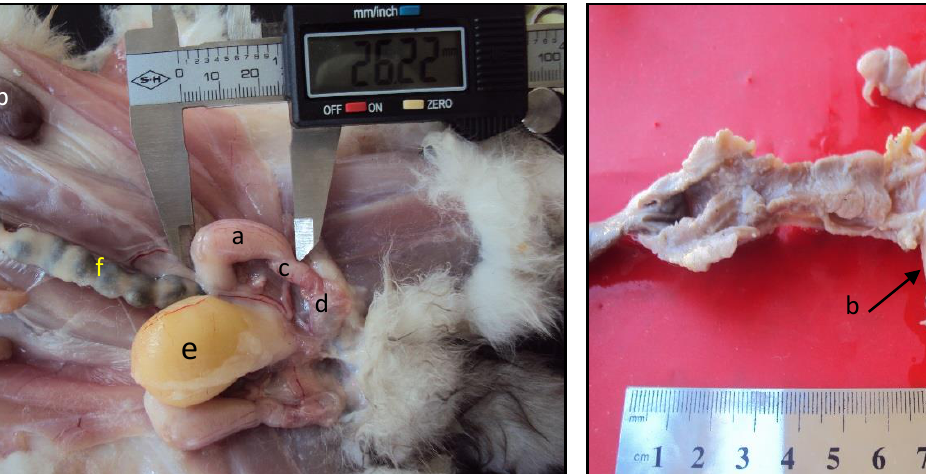
Figure, 7: Shows the testes position of 60 days olds rabbit intra-inguinal canals a- Wall of inguinal canal b- testis.